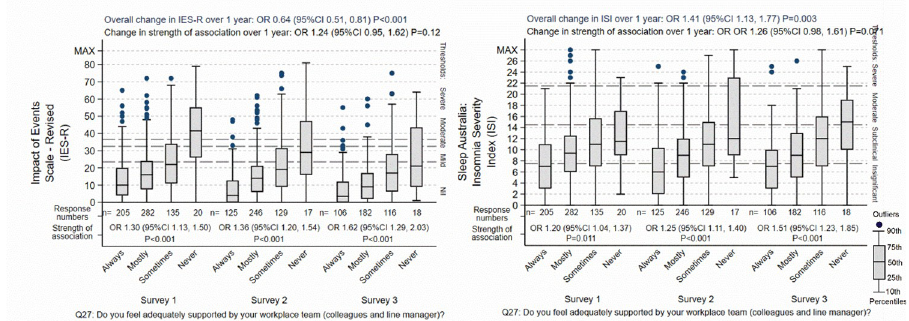
Fig 5. Effect of poor clinical team support on IES-R and ISI. The “Overall change over 1 year” is the background outcome scale O.R. for change in the respondents not explained by the predictor variable included in the regression models. The “Change in strength of association” is the O.R. for the change of the association of the specific predictor shown in the graph over 1 year, adjusted for the other predictors in the regression models. The box-plots display the group score distributions without adjustment for other predictors. The number of specific responses to the questions are shown at each response and survey period. The “Strength of association” is the association of between the outcome and predictor at each survey